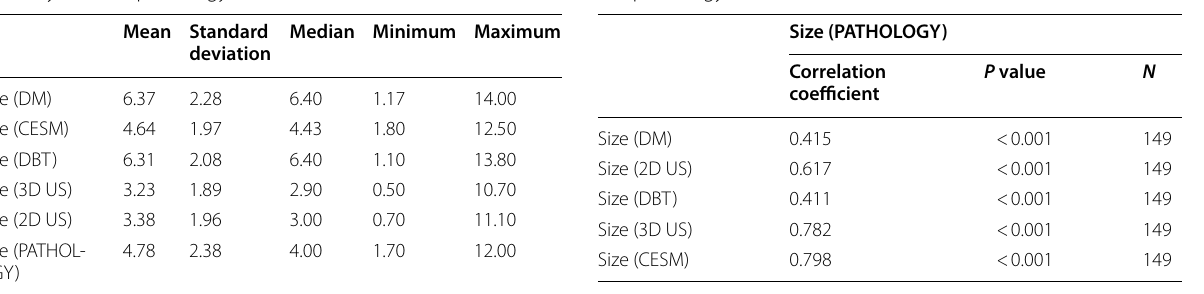
Table 2 The correlation between the different modalities and the pathology